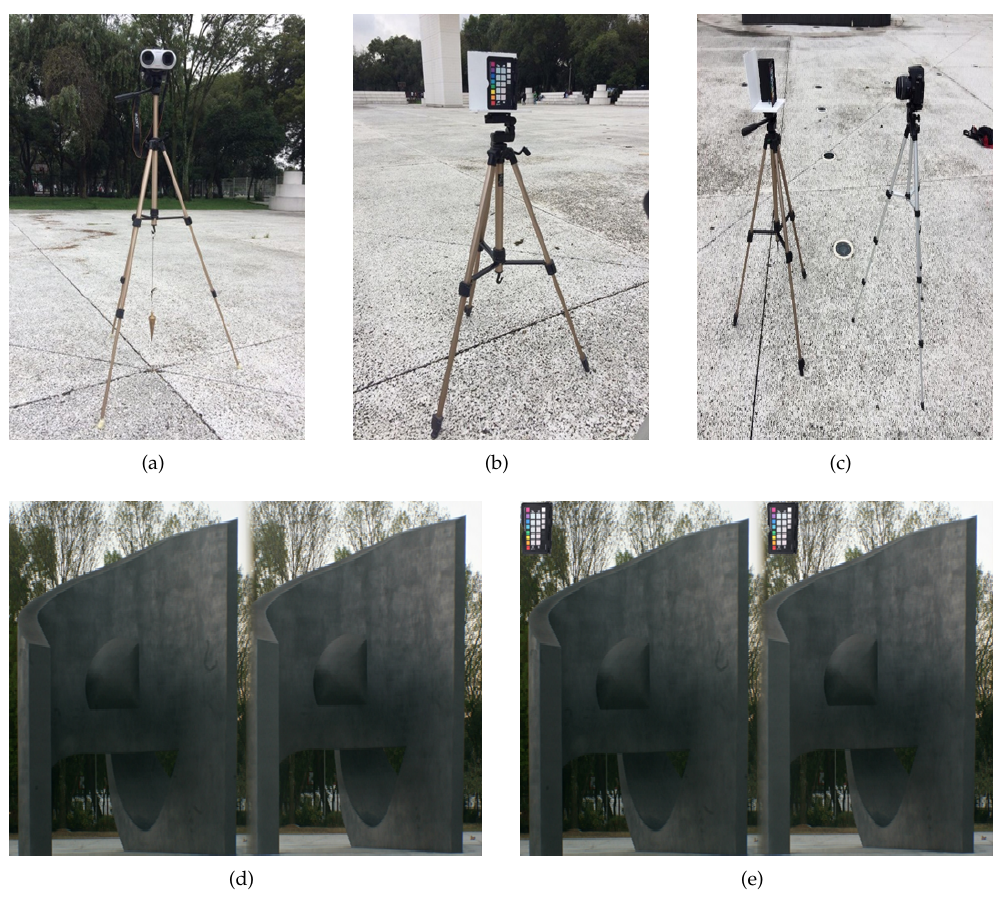
Figure 11. Source Outdoors Images: ( a ) Sony α 230 camera with LOREO Lens, ( b ) Color Checker Passport , ( c ) Capture of Color Checker Passport in a 2D-Image, ( d ) original scenario, and ( e ) scenario with Color Checker Passport superimposed.